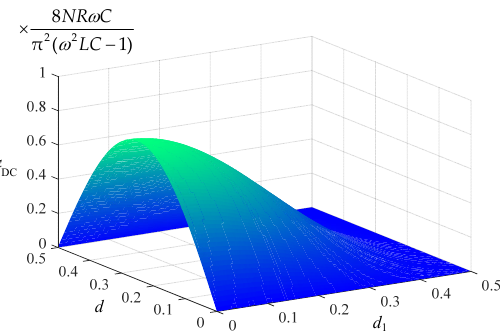
Figure 4. The output voltage gain of LLC ‐ DAB converters with DPS modulation.